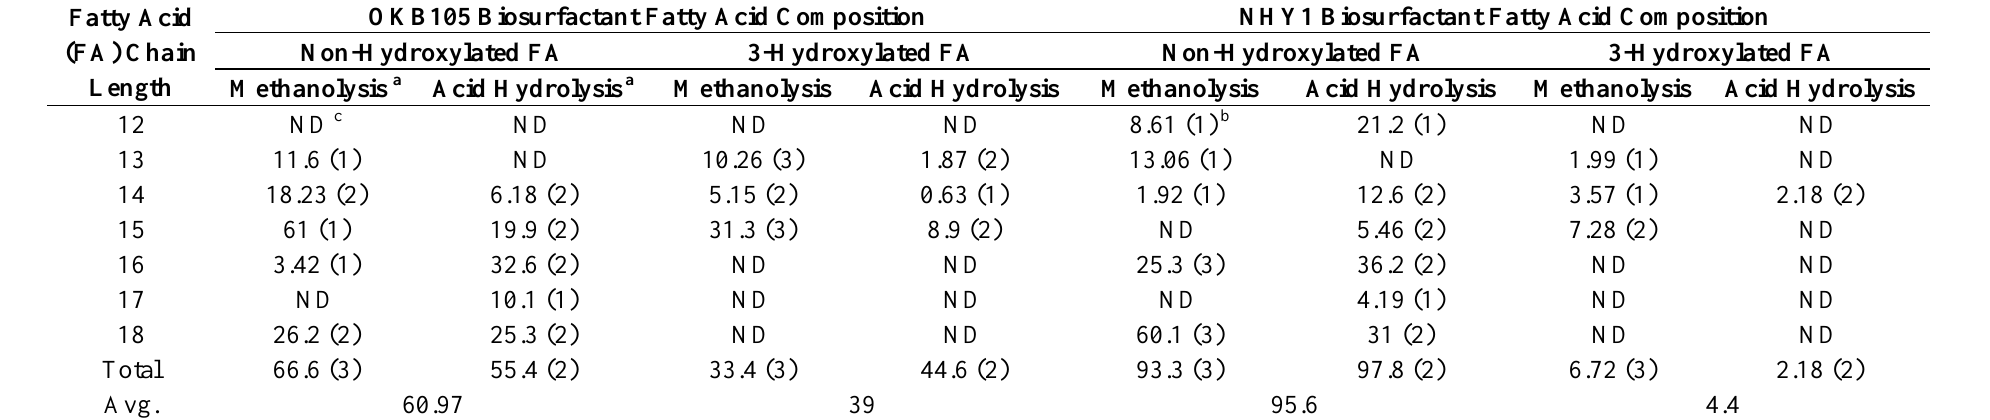
Table 2. Fatty acid composition of OKB105 and NHY1 biosurfactants.